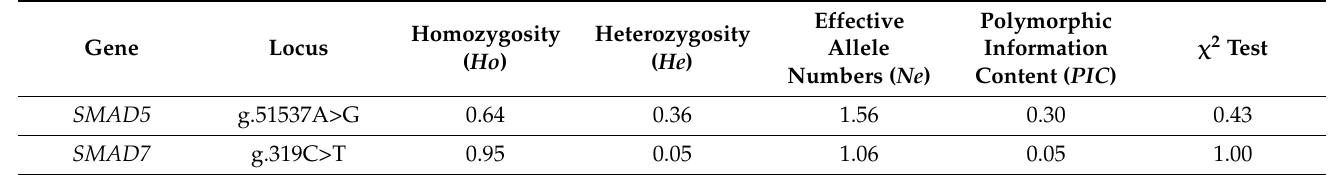
Table 3. Population genetic analysis of single nucleotide polymorphism loci of SMAD5 and SMAD7 in Tibetan sheep.